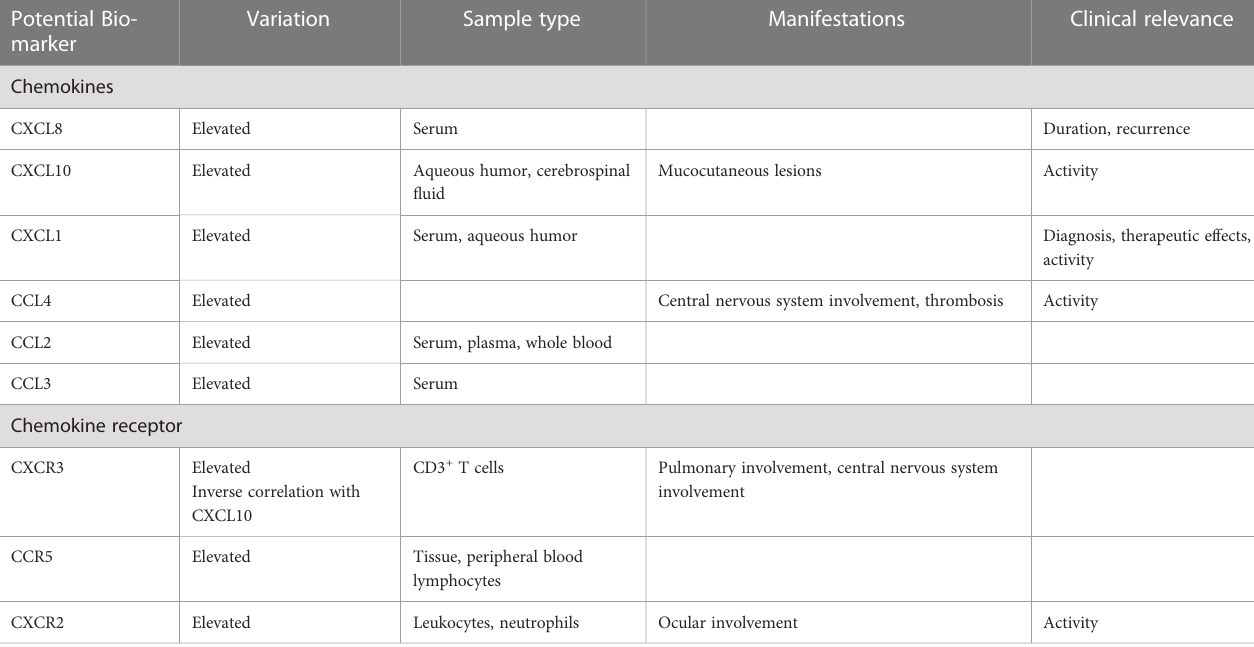
TABLE 1 Chemokines and chemokine receptors with potential for BD laboratory biomarkers. Potential Bio-